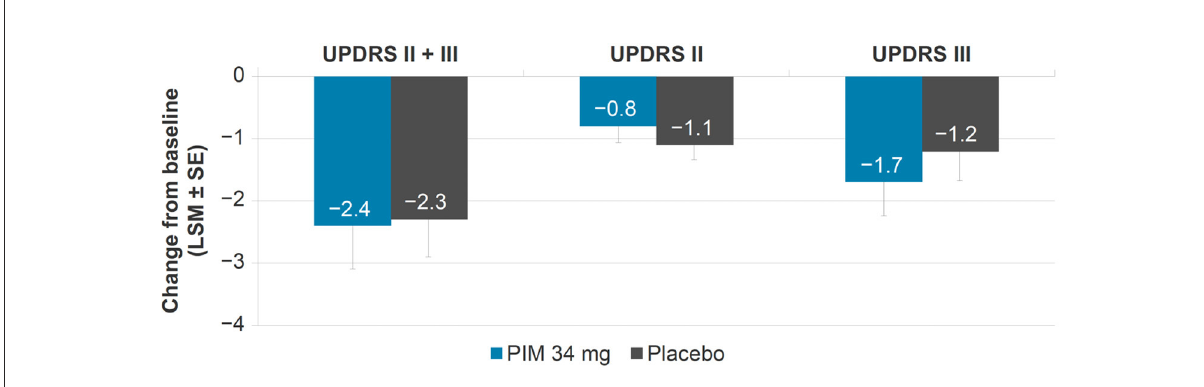
FIGURE1 Change from baseline in UPDRS II, III, and II + III, pooled studies 012, 014, and 020 (pimavanserin 34mg). LSM, least squares mean; PIM, pimavanserin; SE, standard error; UPDRS, Unified Parkinson’s Disease Rating